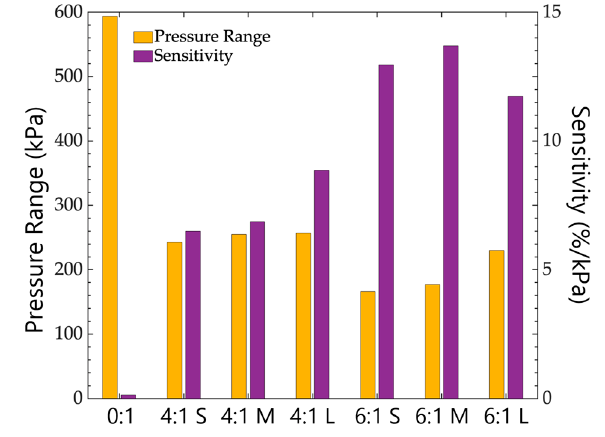
Figure 8. Sensitivity and pressure range of the fabricated sensors according the used bulk PDMS or PDMS foams. Sugar:PDMS ratios were 0:1, 4:1, and 6:1, and the pore sizes were small (S), medium (M), and large (L).